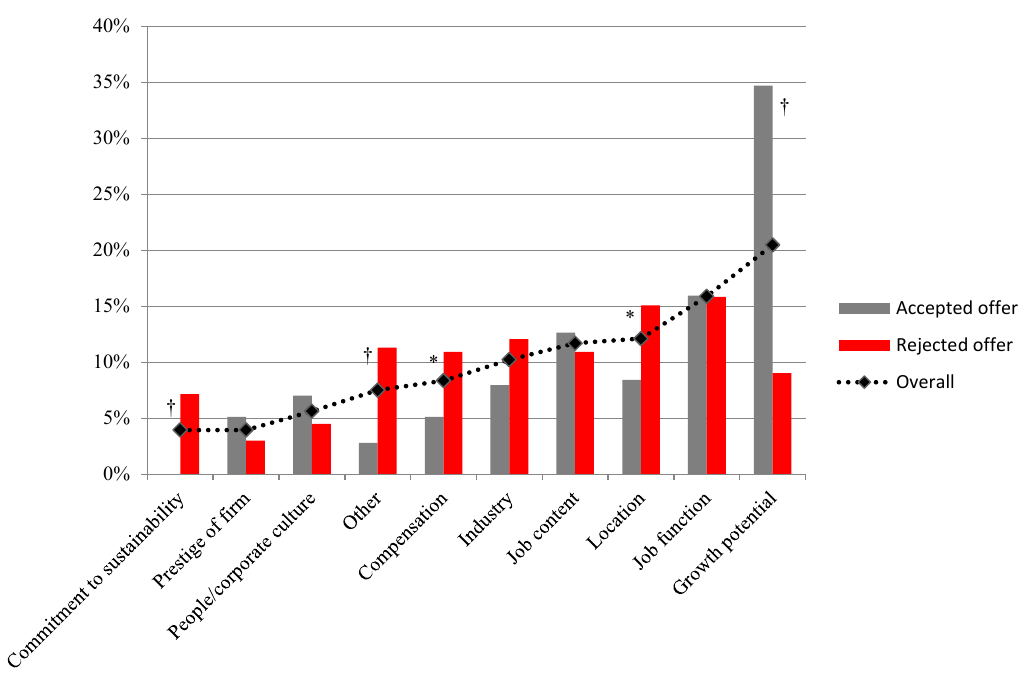
Figure 3: Percent of Respondents Citing Each Reason for Accepting/Rejecting an Offer Note: Source : Proprietary data from a perennial top US business school. Vertical bars indicate the primary reason a student cited for accepting (grey) or rejecting (red) a specific job offer. Triangles denote the combination of the two data points. The unit of analysis is the job offer within and between students with more than one offer (N=478). Bars compared using t-tests assuming unequal/equal variance yield similar results. *= p <.05, † = p <.01 (two-tailed).